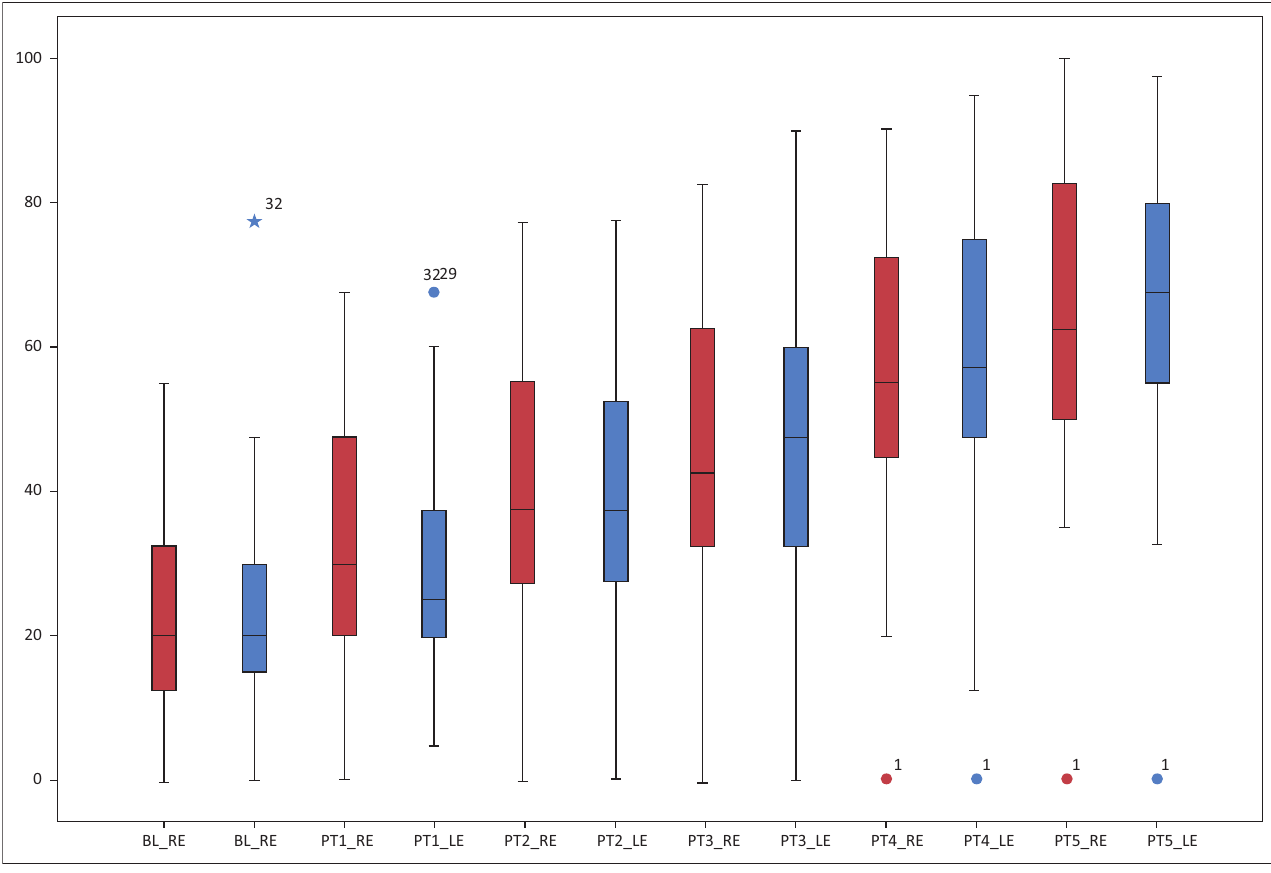
FIGURE 6: High frequency threshold changes over treatment